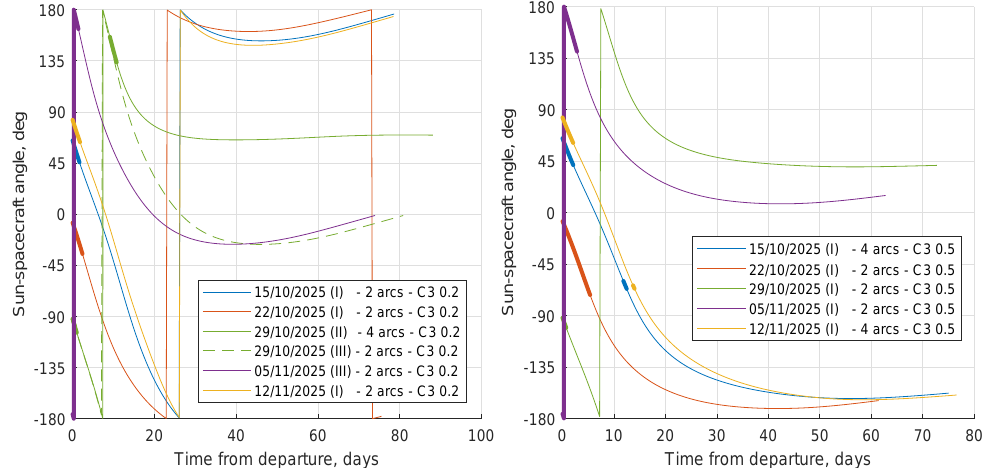
Figure 19. Time evolution of Sun–spacecraft relative angle for all EML2 solutions—fixed C 3 = 0.2 (km/s) 2 ( left ), 0.5 (km/s) 2 ( right ), free t f .